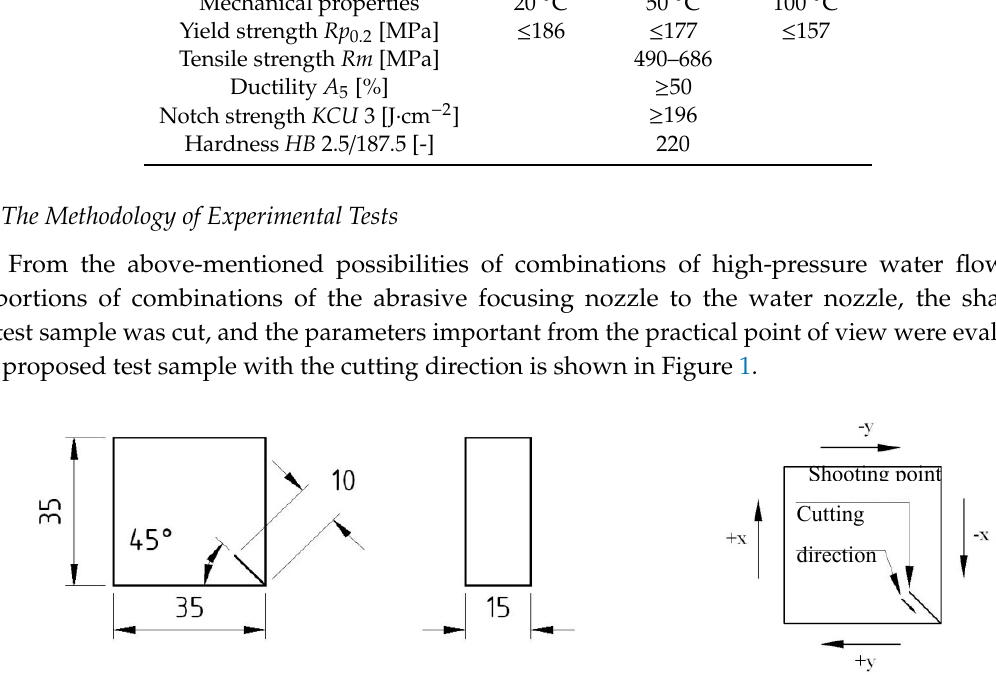
Figure 1. Test sample with the determination of the cutting direction.